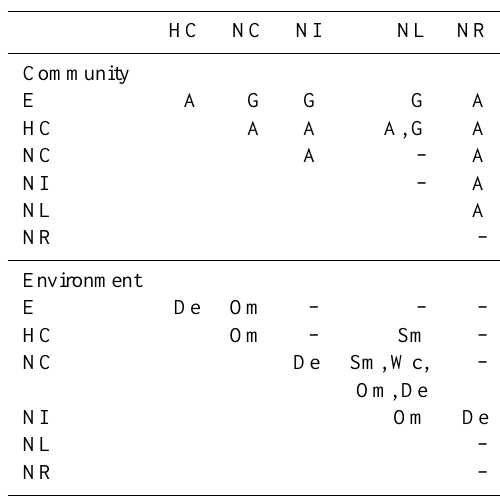
Table 2. Statistically significant (corrected p< 0 . 05) differences be- tween the sites in their community structures (ANOSIM results) and environments (ANOVA